Question: Identify the chart type used in this figure.
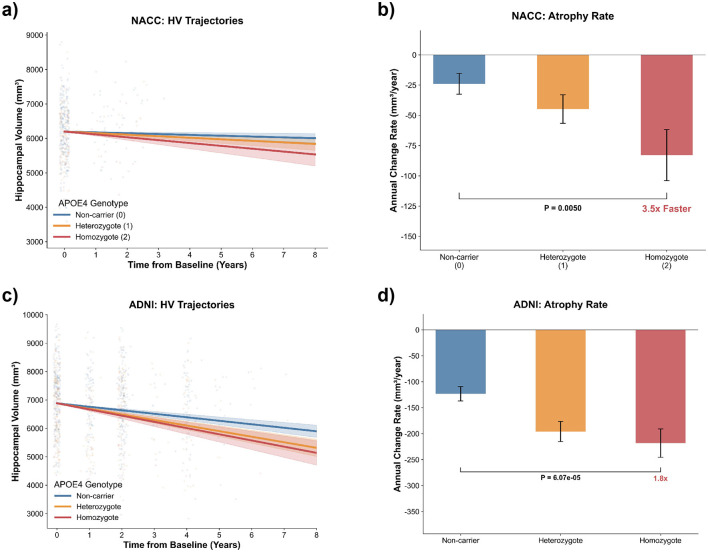
Answer: bar